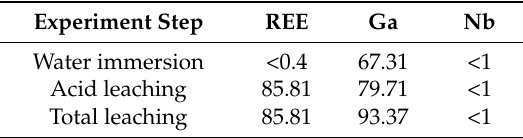
Table 7. Leaching efficiency of verifying sample